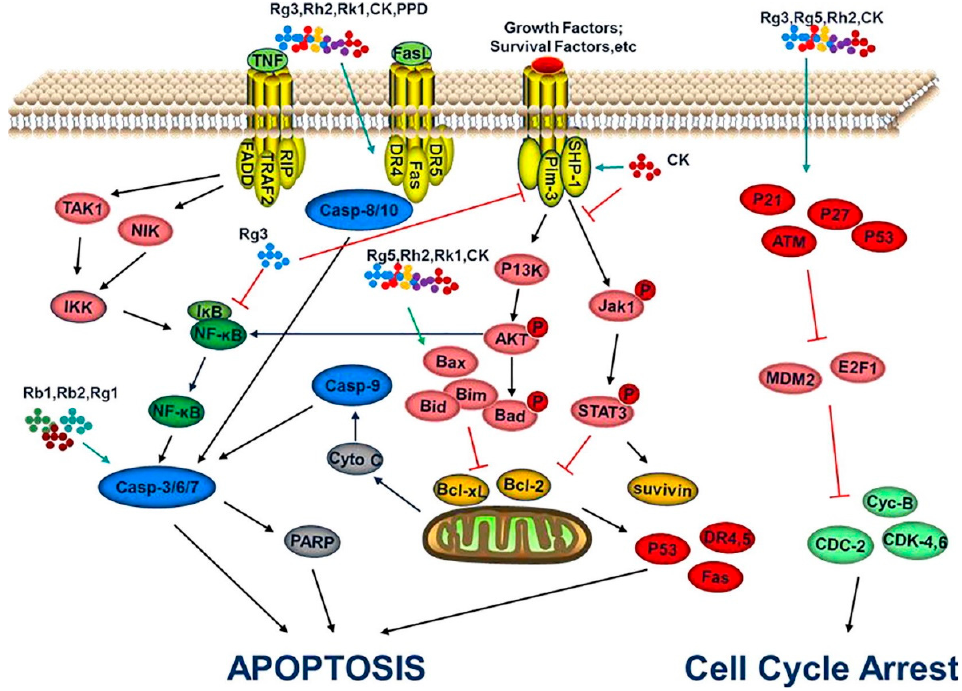
Figure 9. Molecular mechanism involved in tumor growth regression using ginsenosides. Reprinted with permission from Ref. [136] . 2018, Elsevier Ltd.